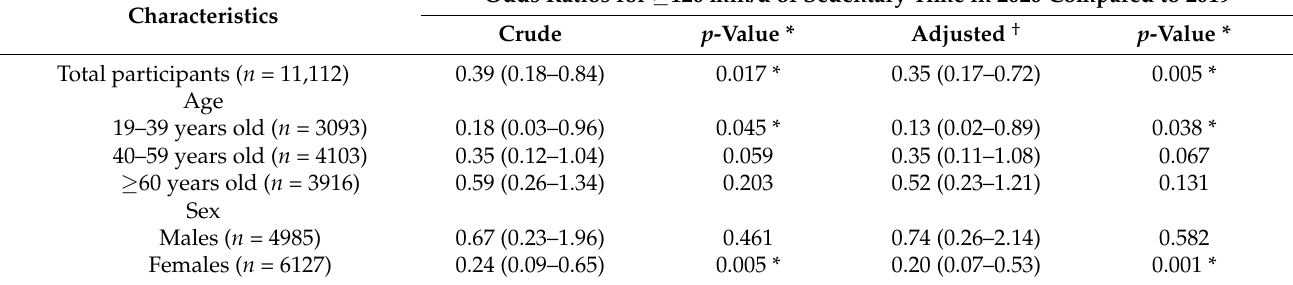
Table 4. Odds ratios (95% confidence intervals) for ≥ 120 min/d of sedentary time in 2020 compared to 2019 with subgroup analyses according to age and sex.